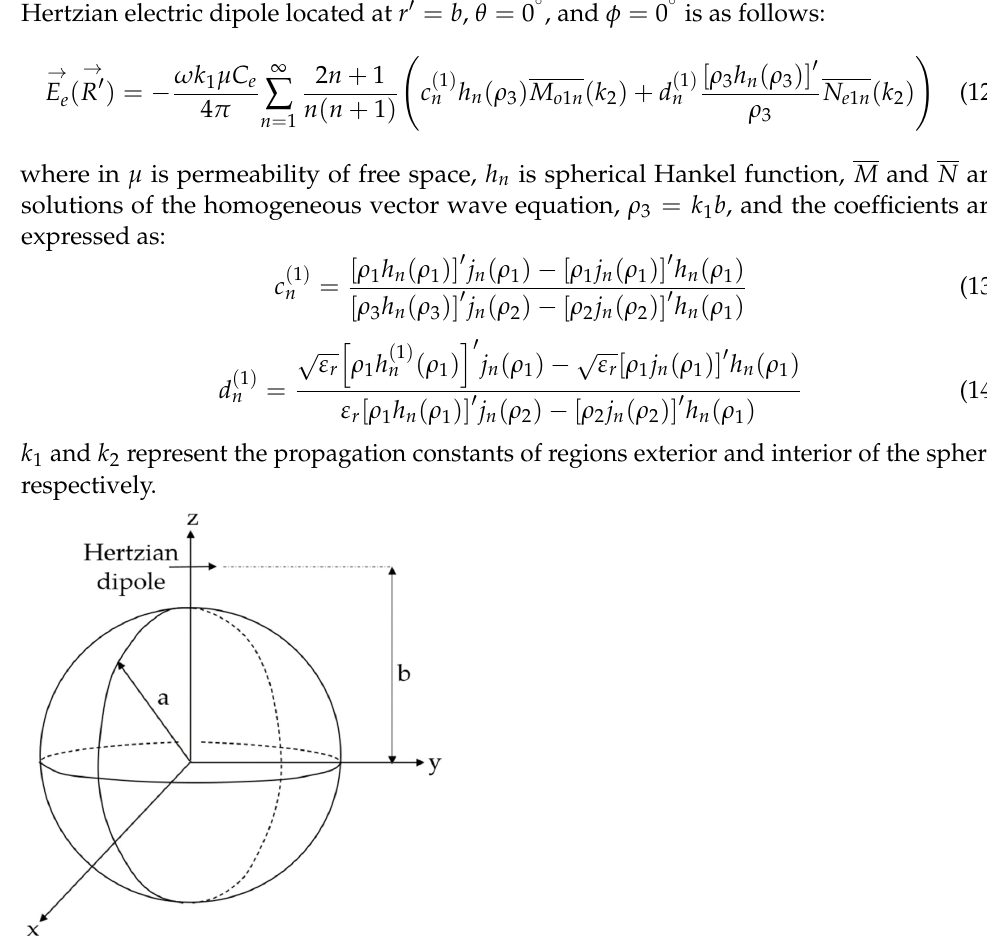
Table 1. Simulation parameters. Parameter Value